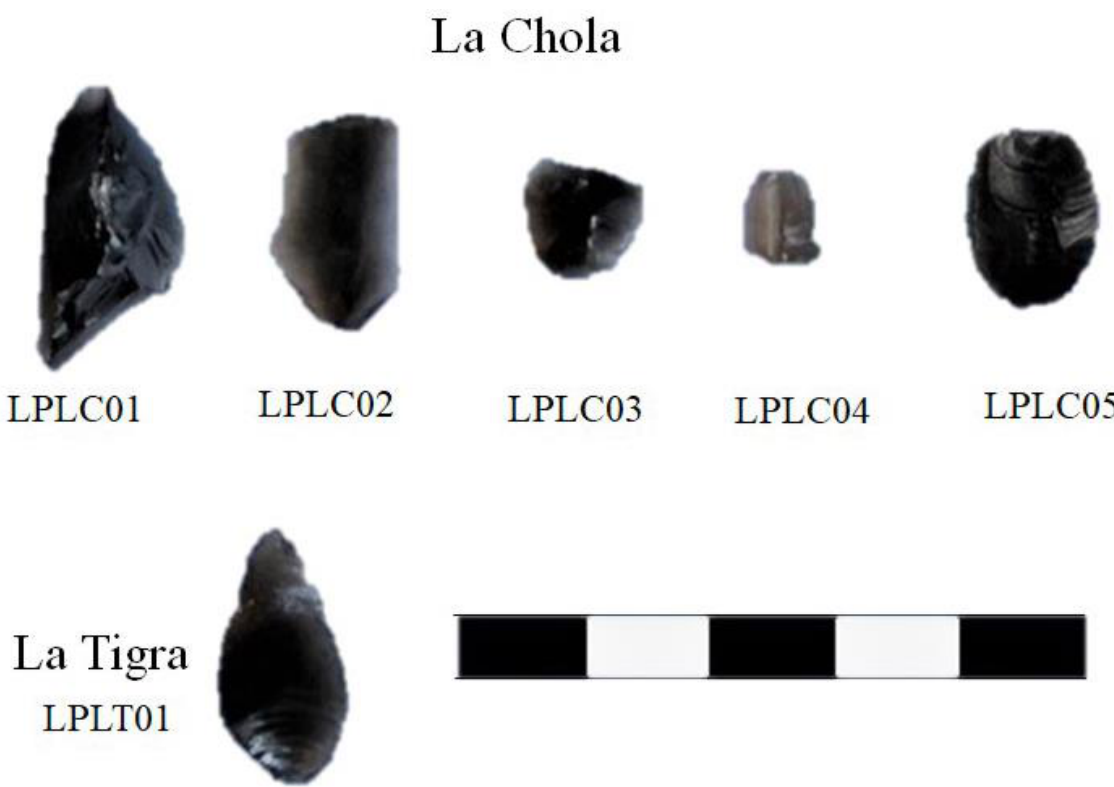
Figure 6. Obsidian artefacts from La Chola and La Tigra sites. Scale bar = 5 cm (1 cm segments). There are also geochemical results coming from archaeological sites without absolute dates that may be chronologically assigned to the Late Holocene. There are three dark black microflakes from the Tapera Moreira locality. Two were found on the surface of Sites 1 and 2. The first sample (LPTM11 from Site 1) corresponds to a source that still remains unidentified (Unknown#5), while the second (LPTMS2 sample from site 2) comes from the Maule 1 - Laguna Negra source. In the Site 3 of the same locality, we recovered a black dark microflake without cortex from level III, associated with human remains (Figure 7). This sample (LPTM13B) also corresponds to a source still unidentified (Unknown #6). The other five samples were recovered in the surface of site La Chola (Bajos sin Salida area) and correspond to different sources. Samples LPLC02, LPLC03 and LPLC04 correspond to translucent black microflakes without cortex and come from the Portada Covunco source.